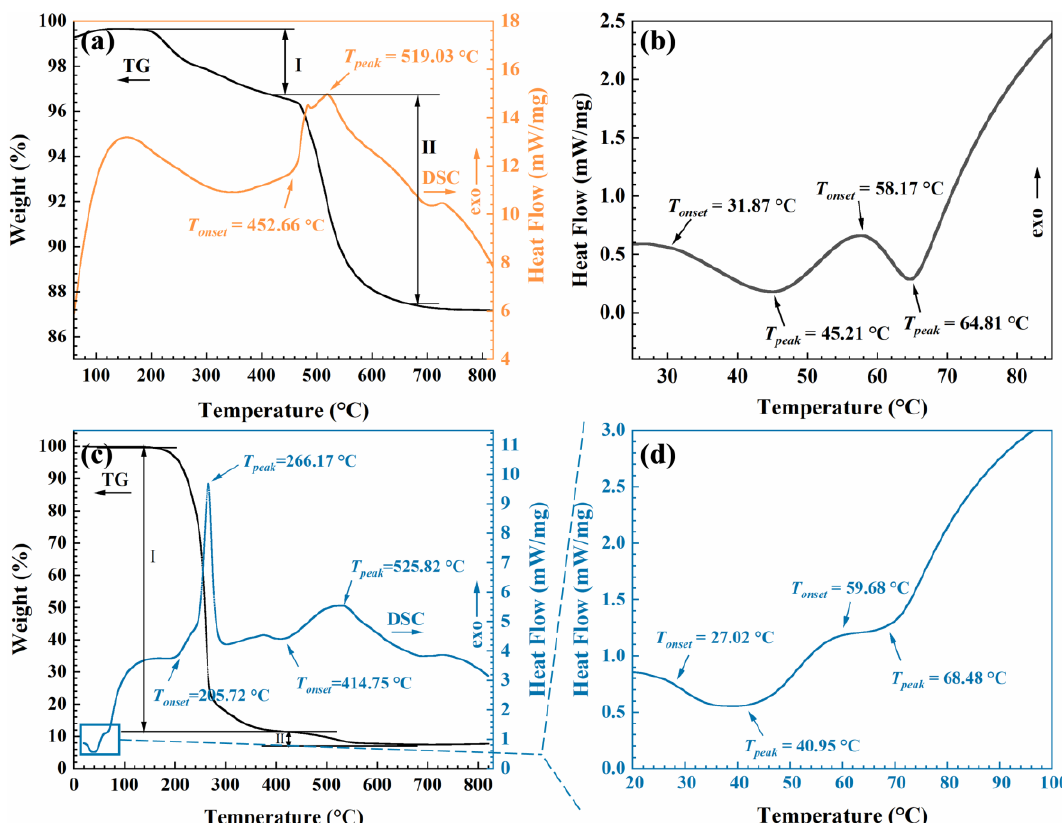
Figure 7. TG or DSC curves of ( a ) the MSA, ( b ) paraffin and ( c , d ) paraffin/MSA